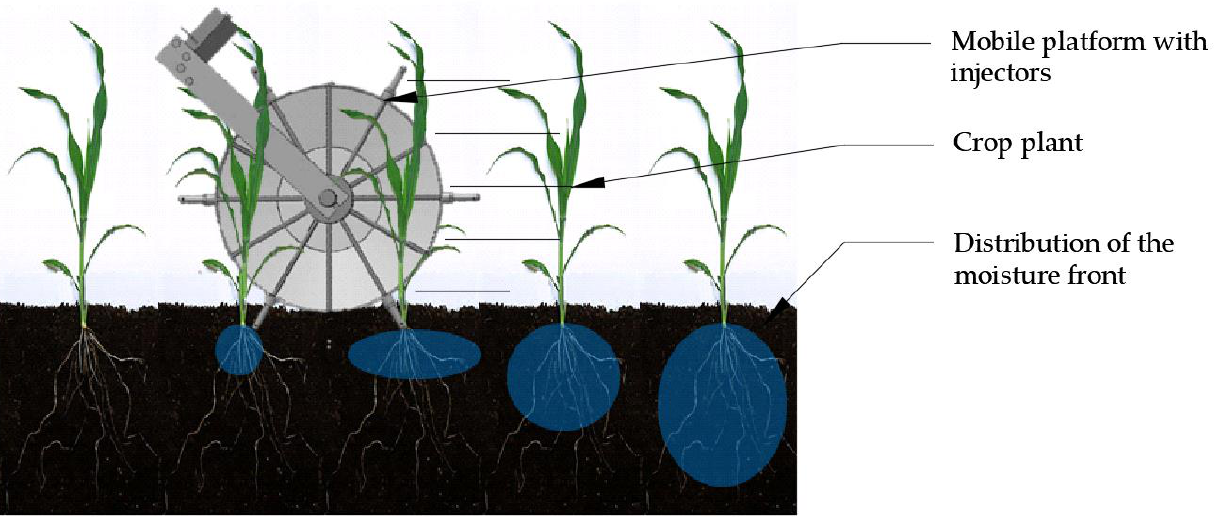
Figure 1. Schematic presentation of the concept of a platform for injection irrigation with a possibility of fertilization [9].